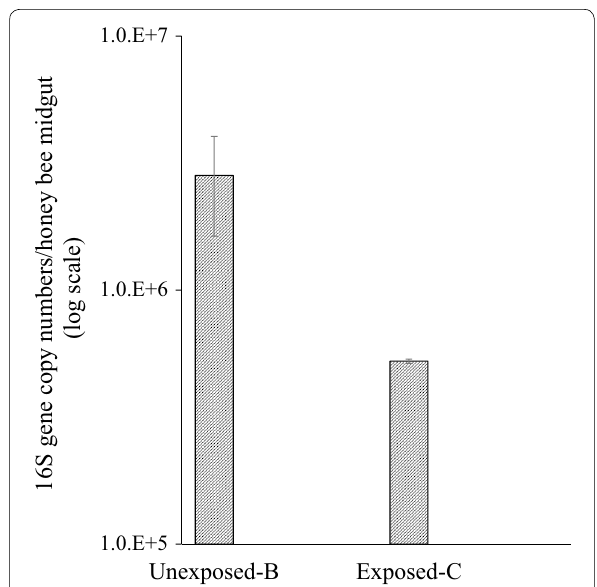
Fig. 4 Average copy numbers of 16S rRNA gene per gut of the unexposed and exposed honey bees to the pesticide of carbaryl. Single‑factor ANOVA at 95% confidence